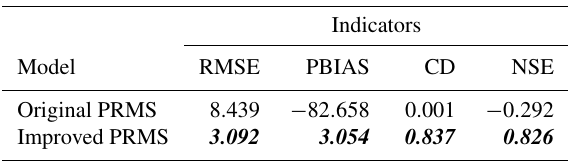
Table 2. Uncalibrated PRMS model result comparisons. Bold italic font indicates a better result.